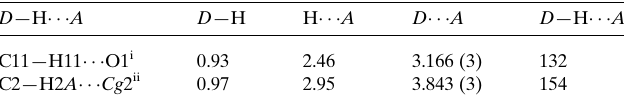
Table 1 Hydrogen-bond geometry (A˚ , (cid:2) ). Cg 2 is the centroid of the C7–C12 ring.